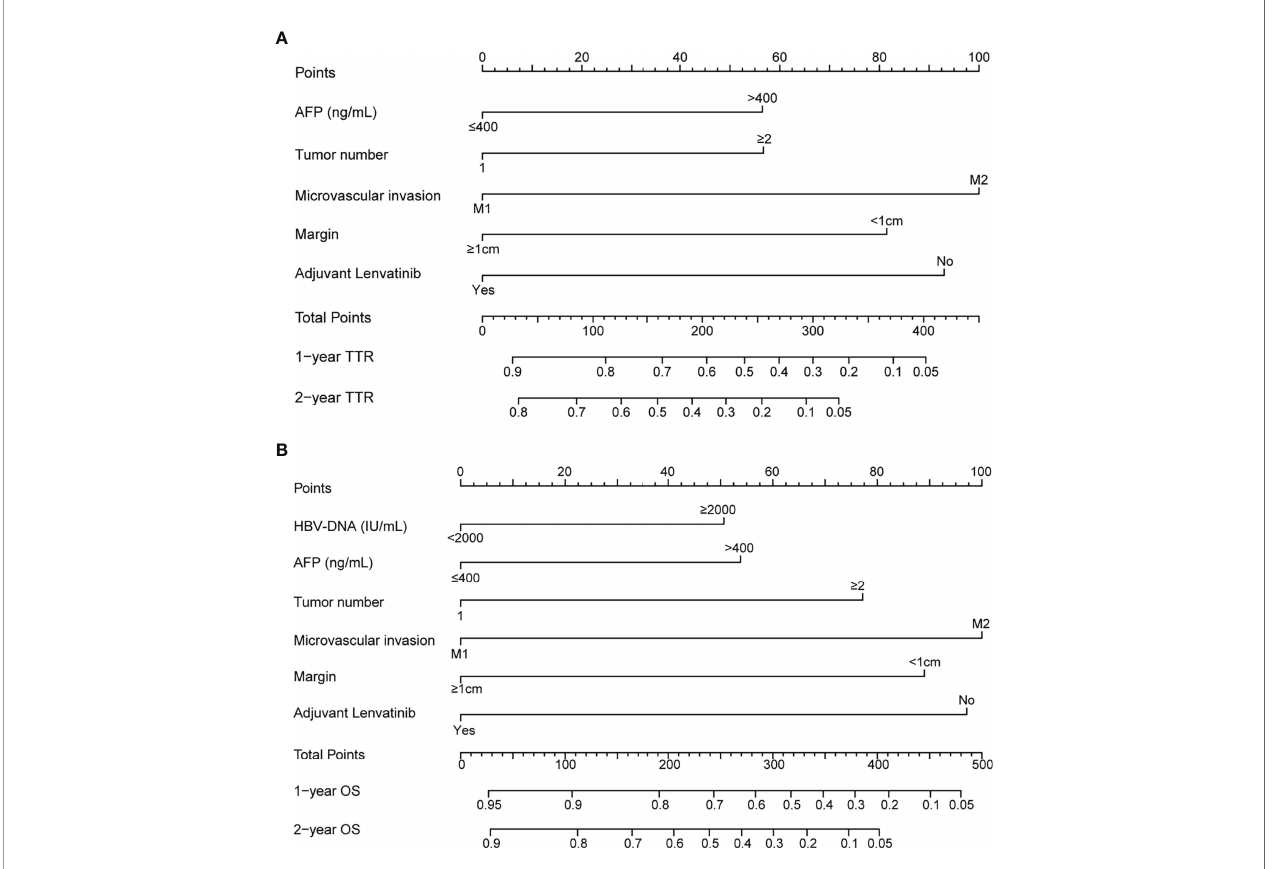
FIGURE 3 | Nomogram for survival of HCC patients with MVI after radical resection. adjuvant Lenvatinib-related nomograms for TTR (A) and OS (B)